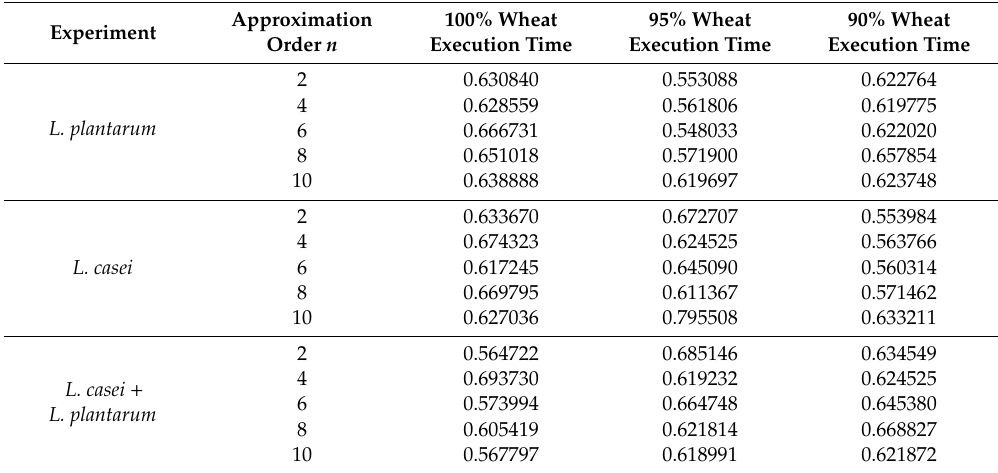
Table 2. Algorithm execution time depending on the fractional-order approximation n .